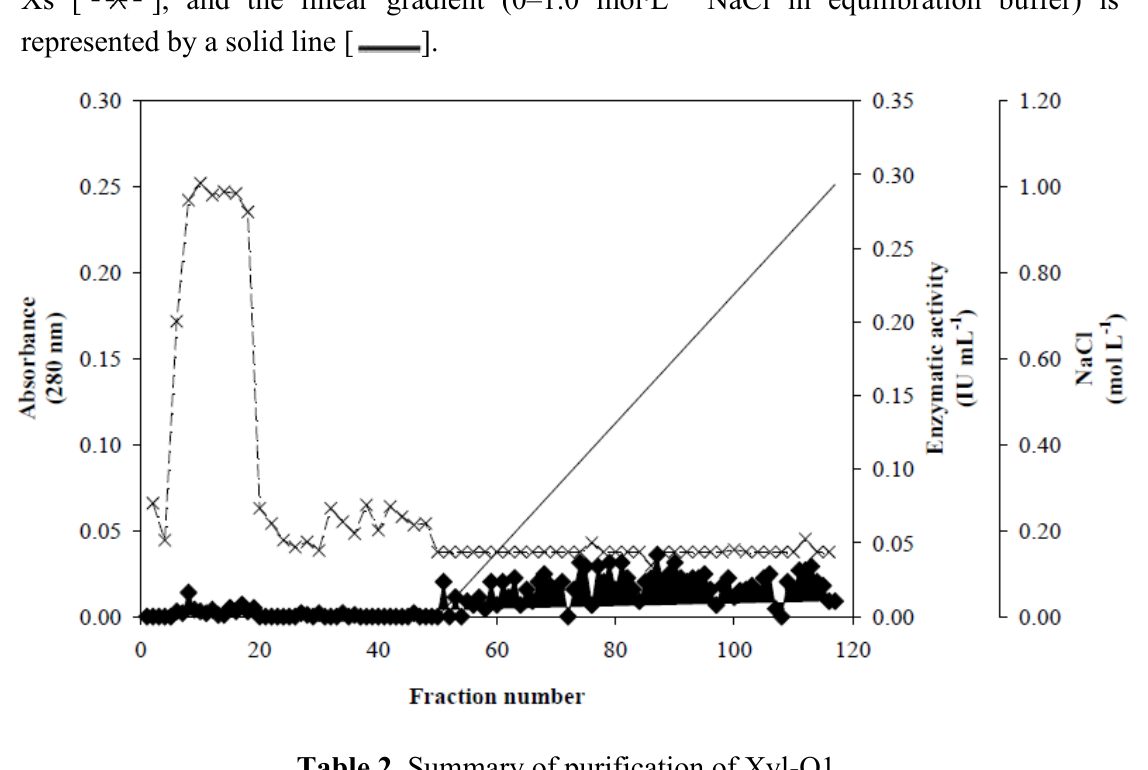
Table 2. Summary of purification of